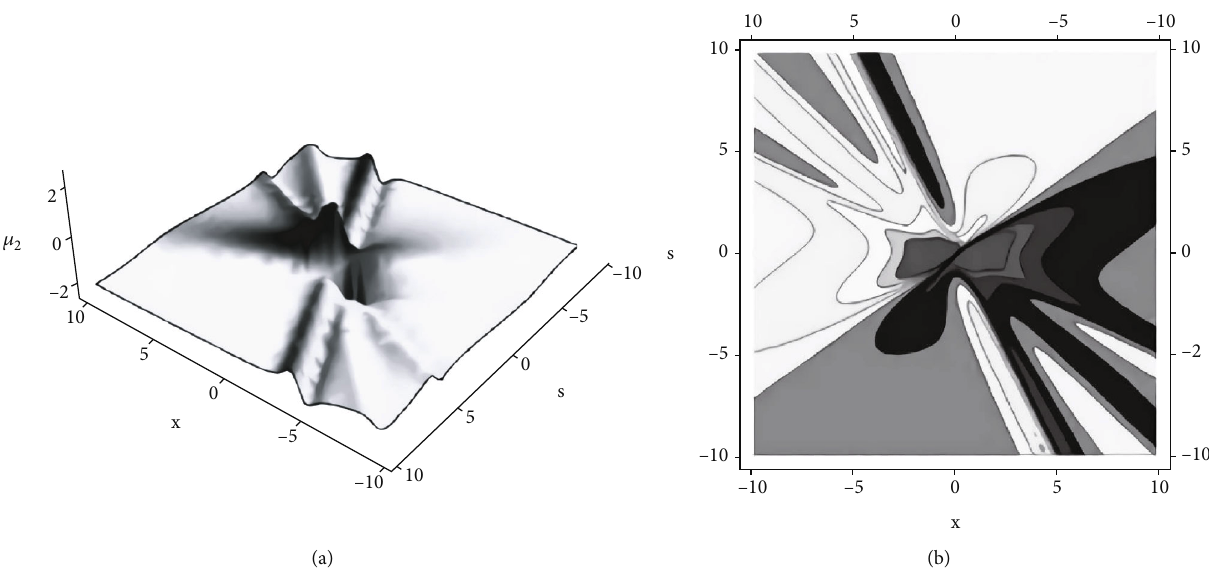
= d = a = m = n = n = q = n = 1 1 2 1 1 2 3 2